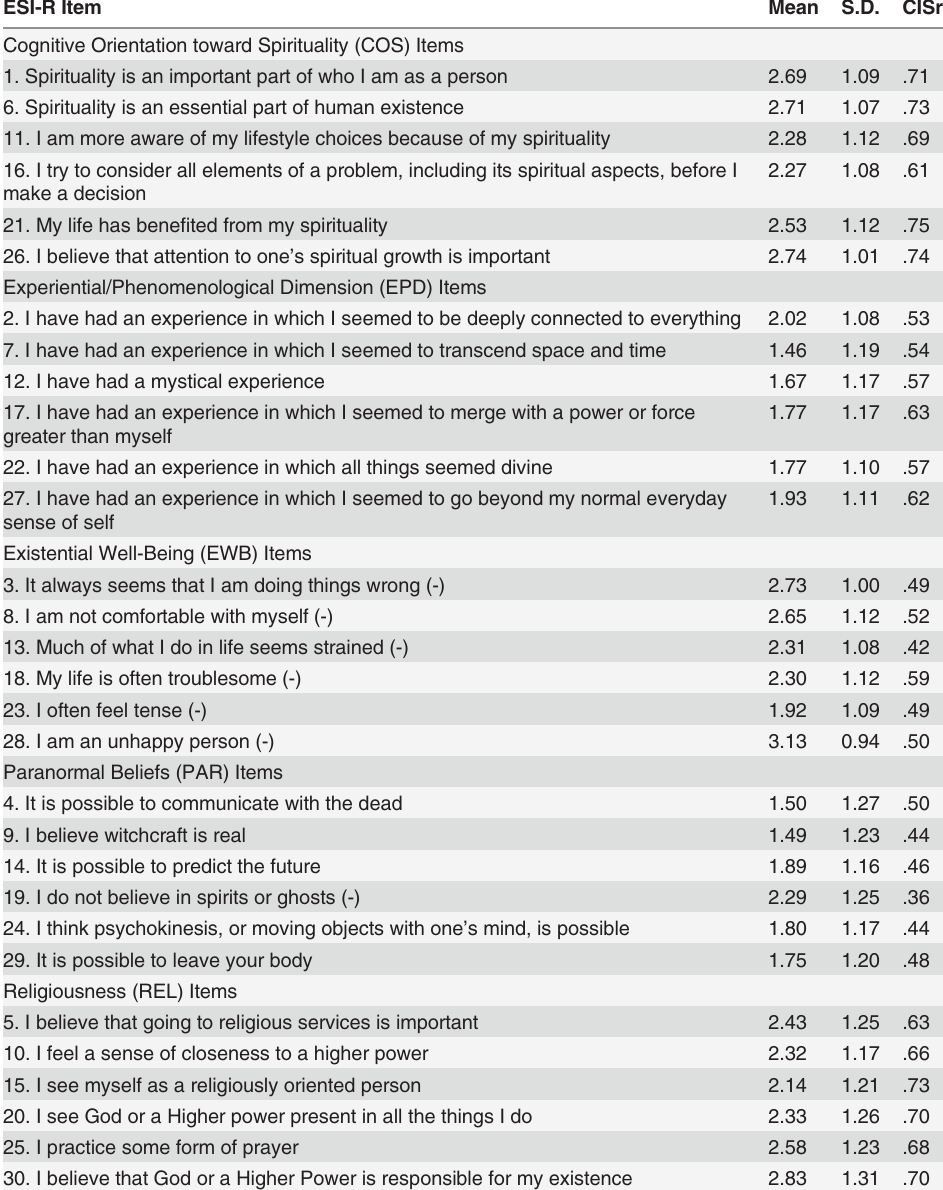
Table 4. ESI-R Item Descriptive and Reliability Statistics for Combined Sample (N = 4004). ESI-R